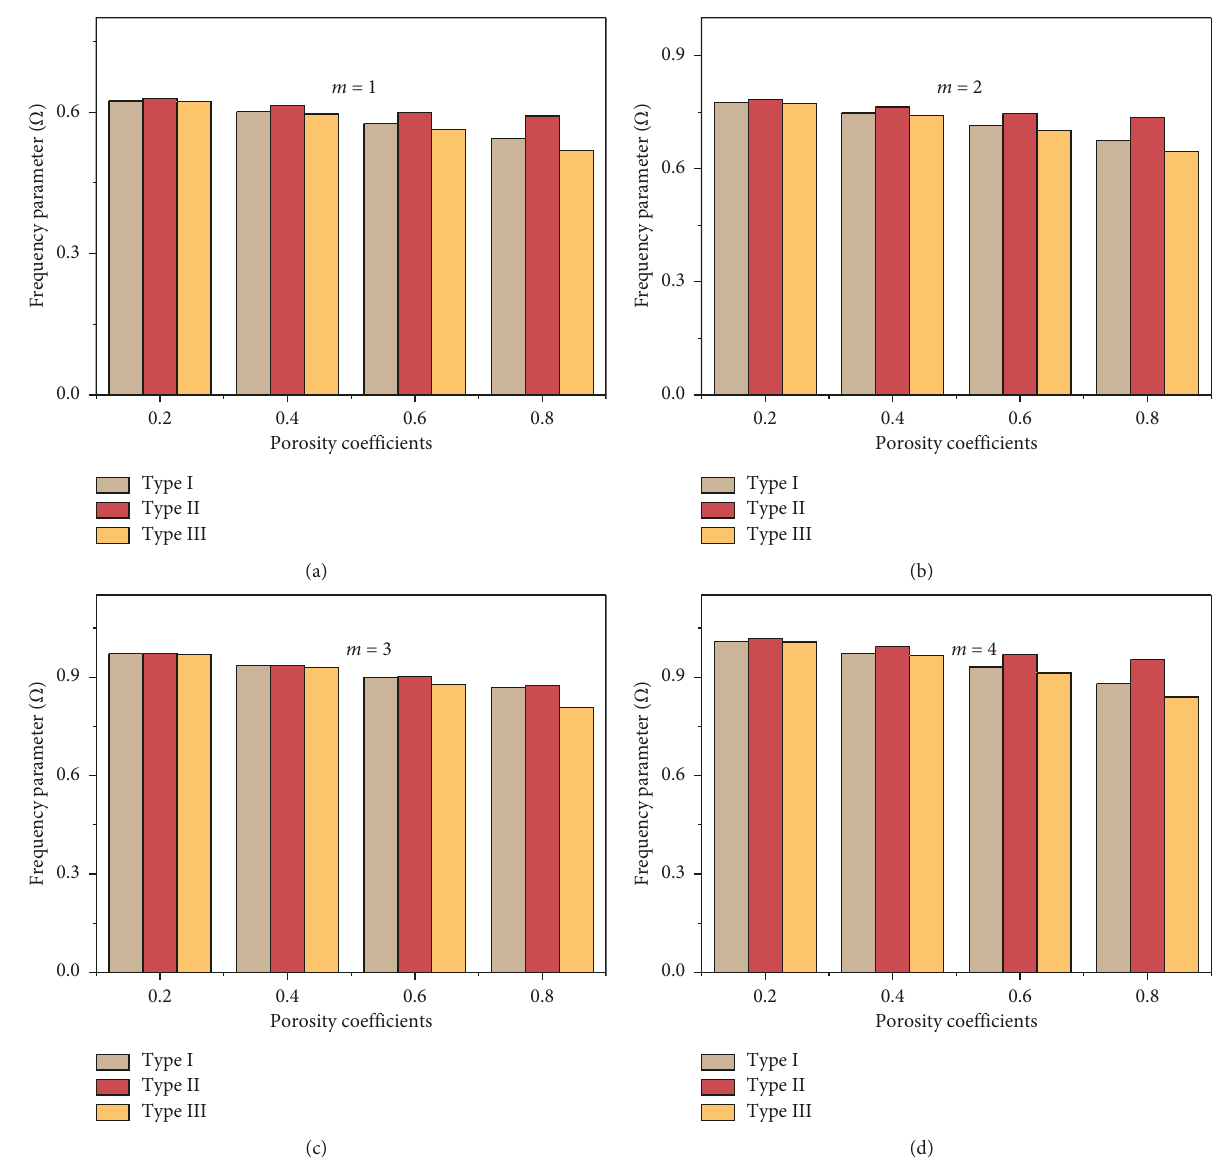
Figure 6: Nondimensional frequency parameter of CCCC porous rectangular plates with different porosity